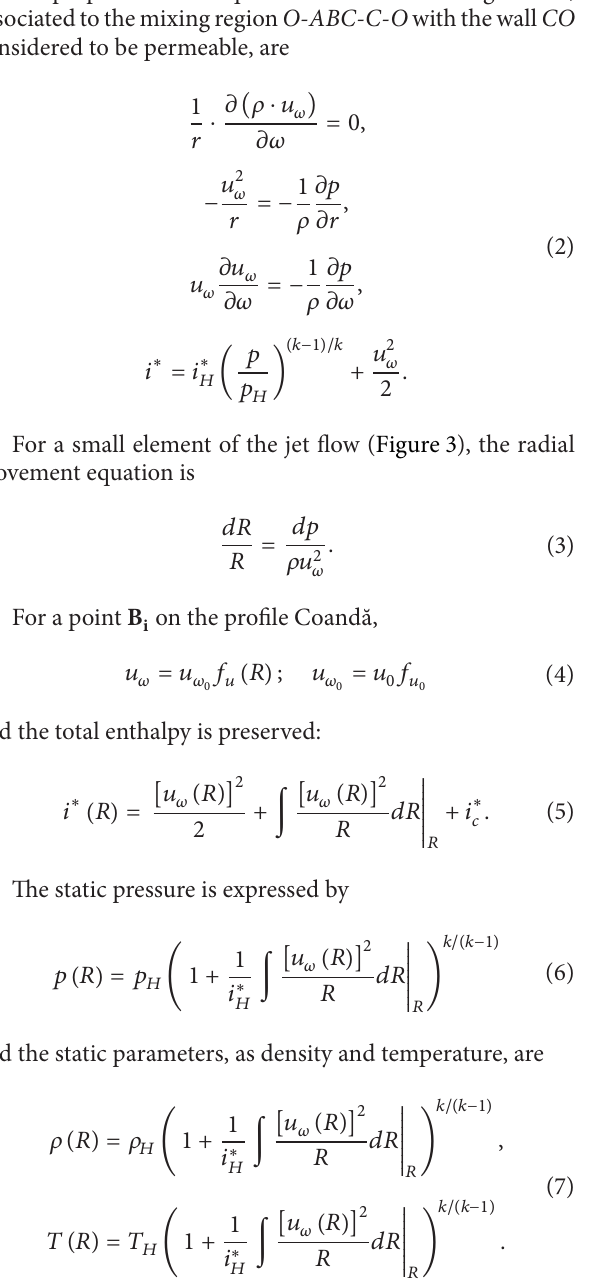
Figure 1: Coand˘a effect flow